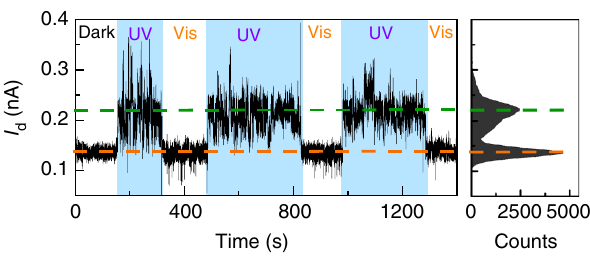
Fig. 4 Photoswitching behaviours. At low bias voltages, real-time measurements reveal reversible switching between cis and trans forms of TTDA upon exposure to UV and visible light irradiations, respectively. The right panel is the corresponding statistic histogram, showing that the conductance of cis form is higher than that of trans form. The source-drain voltage is 0.01 V; the gate voltage is 0 V